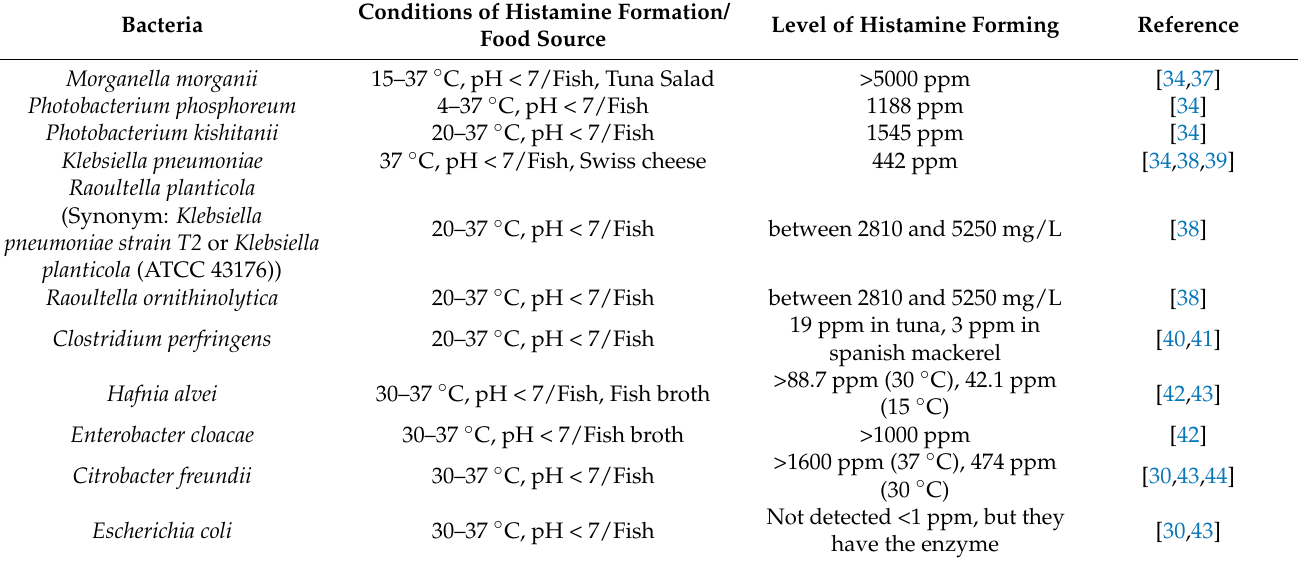
Table 1. Bacteria species that can produce histamine and their